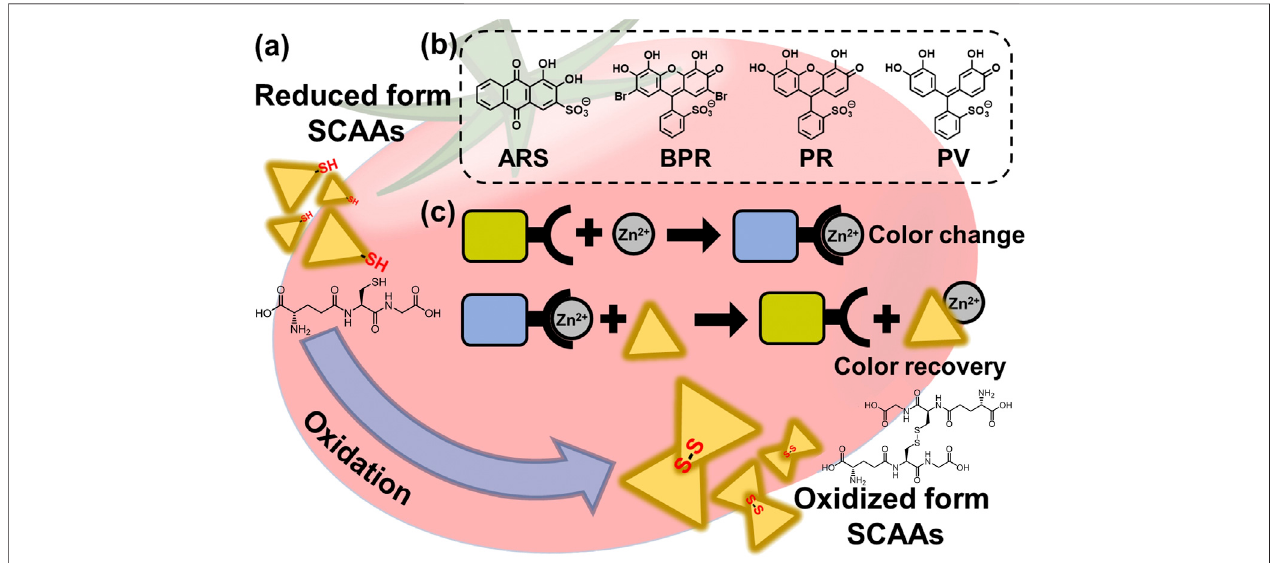
FIGURE 1 | (A) Schematic illustration of the SCAA oxidation (e.g., glutathione). (B) Chemical structure of catechol dyes (PV, BPR, PR, and ARS). (C) Illustrated detection mechanism of SCAAs.